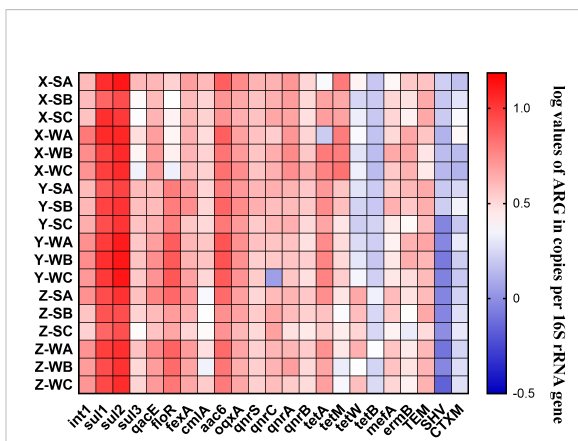
FIGURE 2 Heat map of the relative abundance of ARGs in each sample. X, Y, and Z indicate the fi ngerling, rearing, and harvesting stages, respectively; S and W indicate pond water and sediment samples, respectively; and A, B, and C indicate three different